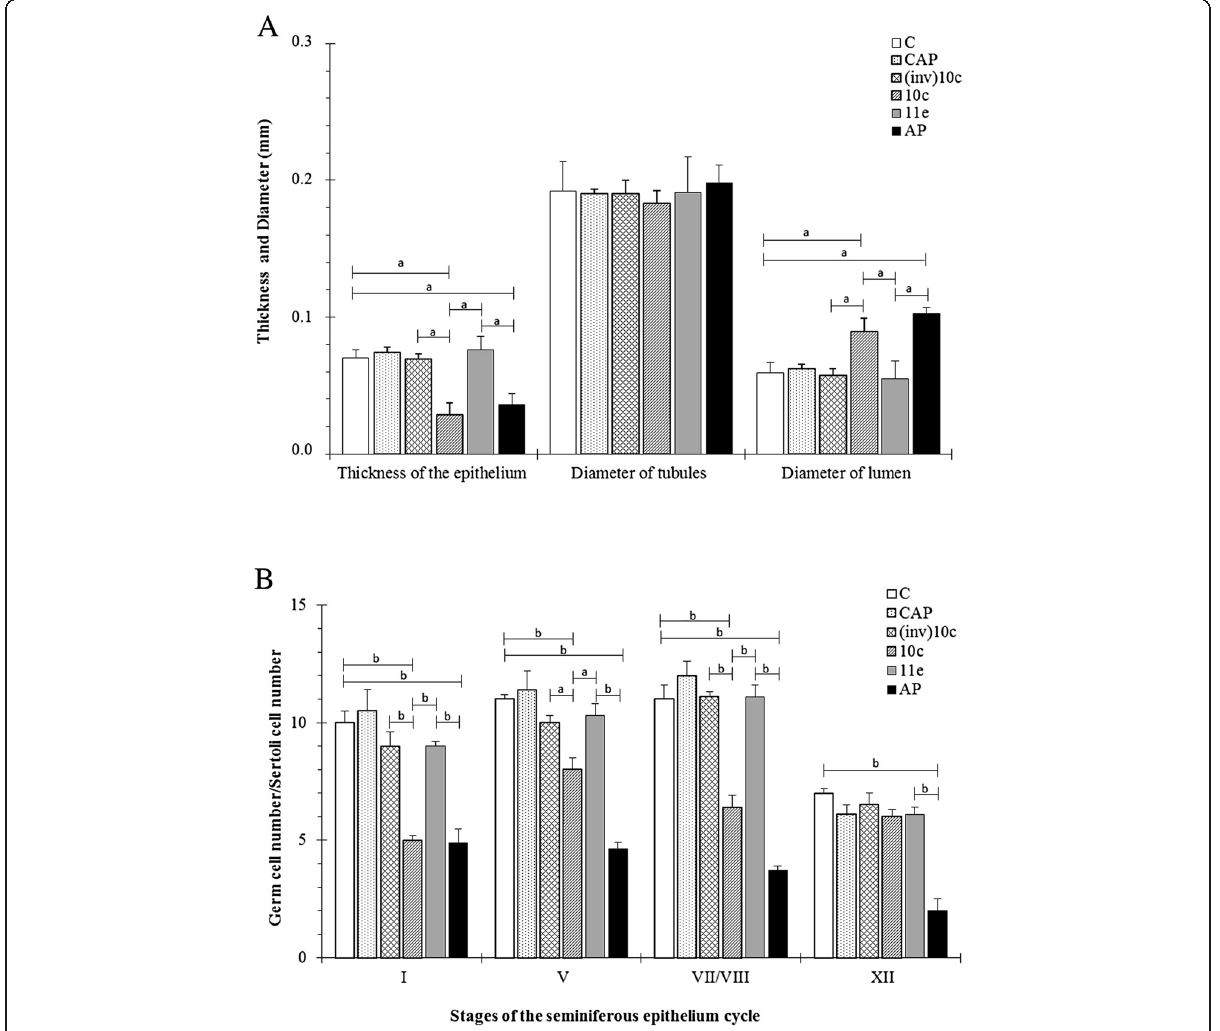
Fig. 2 Morphometric aspects of the seminiferous tubules in mice treated with angiotensin-converting enzyme (ACE) inhibitors. a Thickness of the epithelium and diameter of tubules and lumen of the seminiferous tubules of control and treated animals. b Total support capacity of Sertoli cells during stages I, V, VII/VIII and XII of the seminiferous epithelium cycle of control and treated animals. The data are presented as the mean ± SEM. The various letters indicate significant differences between the analyzed groups as determined via one-way ANOVA followed by the Tukey test as a post hoc test (a, p < 0.001; b, p < 0.0001). C, control; CAP, captopril; (inv)10c, containing the inverted BPP-10c sequence; 10c, BPP-10c; 11e, BPP-11e; AP,